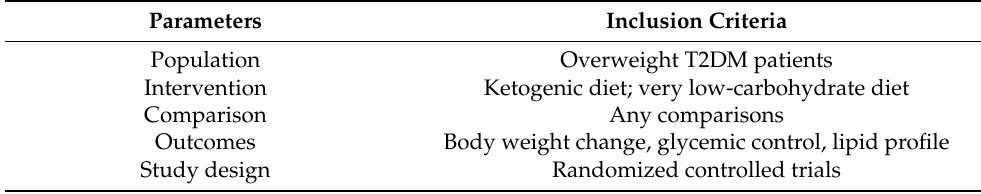
Table 1. PICOS criteria for inclusion and exclusion of